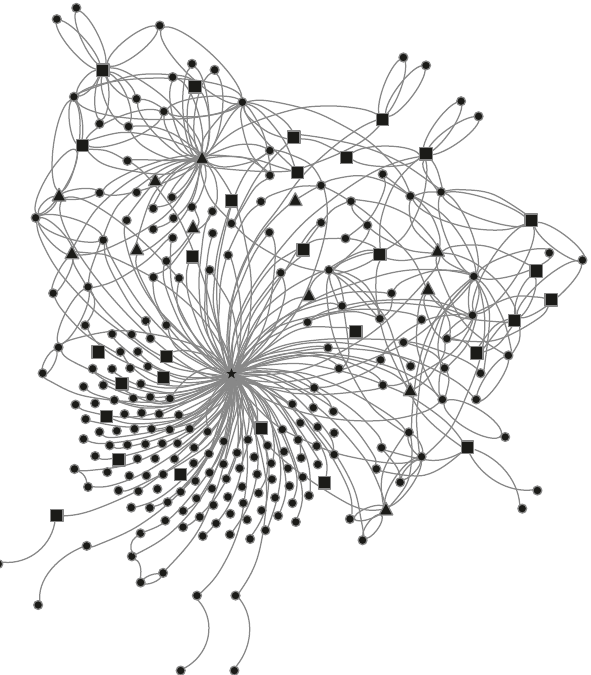
Figure 4: Users that they followed Root after a mention or a RT.